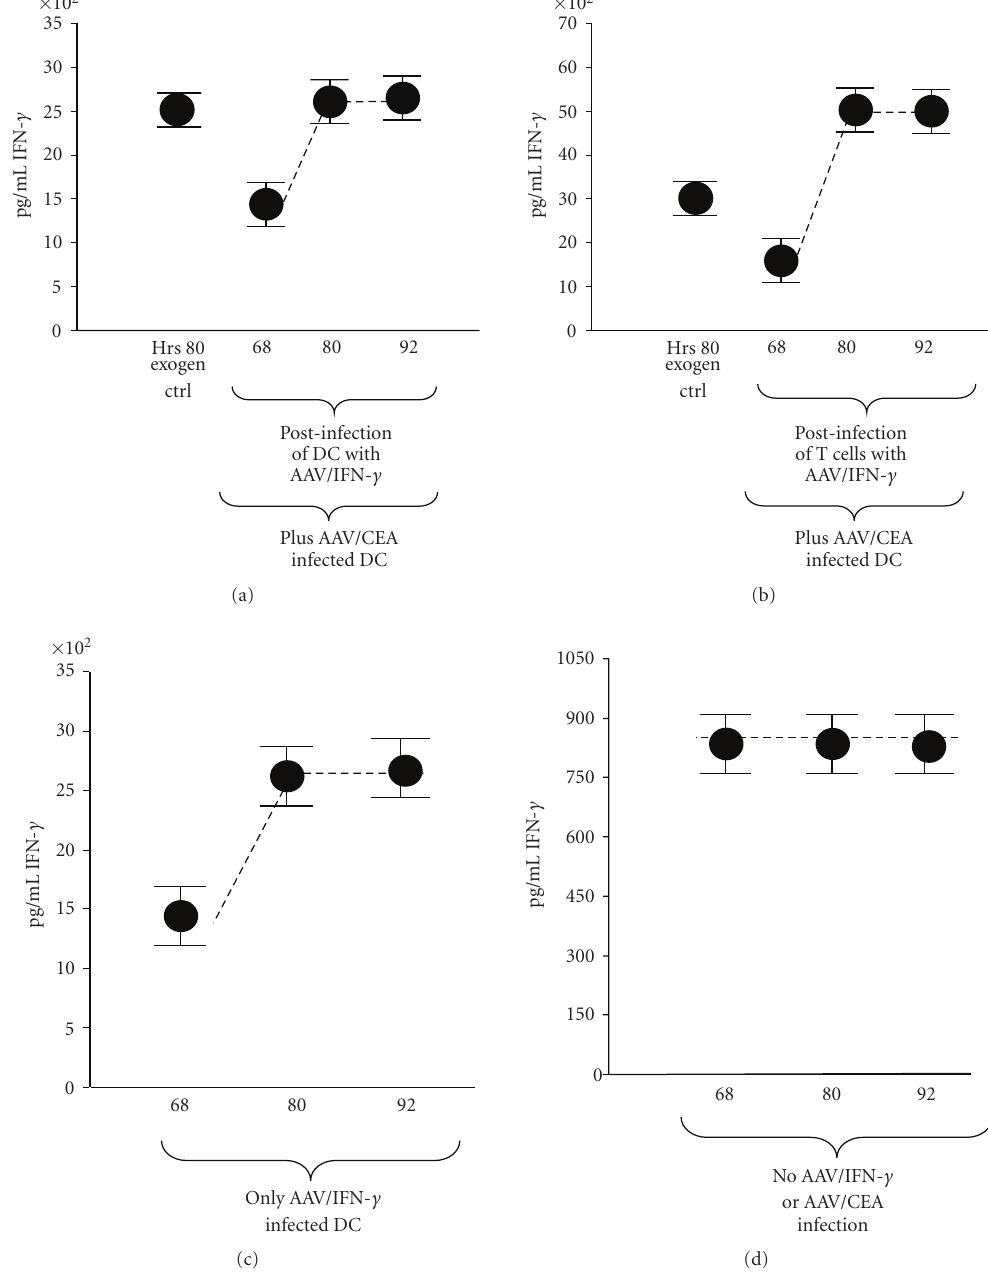
Figure 6: Secretion of IFN- γ from AAV-transduced cells over time. Cells were treated as indicated and secretion of IFN- γ was measured in the conditioned medium at the indicated time by ELISA. The conditions include AAV/IFN- γ delivery into DC (with concurrent AAV/CEA delivery), (a); AAV/IFN- γ delivery into T cells, (b); AAV/IFN- γ only delivery into DC, (c); cells with no treatment,